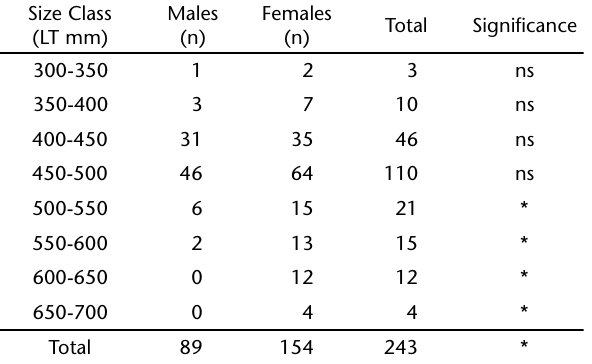
Table III. Chi-square ( (cid:2) 2 ) test for sex ratio comparisons by size classes of M. liza from Sepetiba Bay, 2006/07. (LT) Total length, (n) number of individuals, (*) significant at 95% level of confidence, (ns) non